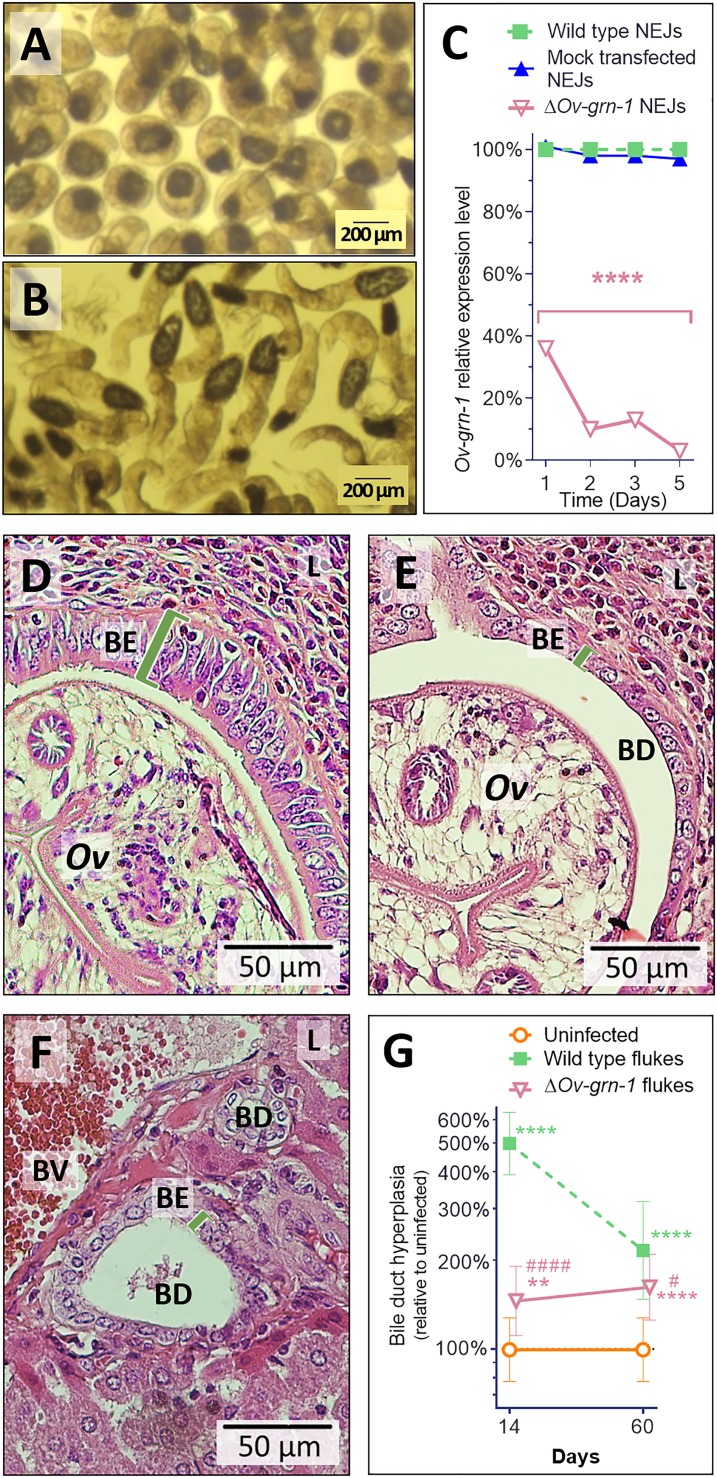
Gene edited ΔOv-GRN-1 newly excysted juveniles infected hamsters but drove reduced acute pathogenic lesions.Micrographs of metacercariae (A) and newly excysted juvenile flukes (NEJ) (B). (C) Levels of Ov-GRN-1 transcripts in mock-transfected and ΔOv-GRN-1 flukes at one to five days as quantified with qPCR and plotted relative to the wild type (WT) untreated group; mean ±SD; three replicates; ****p ≤ 0.0001 compared to WT flukes with two-way ANOVA Holm-Sidak multiple comparison test at each time point. (D) Representative micrograph (200 × magnification) of H&E-stained thin sections from livers of hamsters at 14 days after infection with WT flukes. (E) Representative micrograph of H&E-stained thin sections showing hamster liver 14 days after infection with ΔOv-GRN-1 flukes. (F) Representative micrograph of H&E stained thin sections of livers of control, uninfected hamsters, revealing the healthy, organized pavement-like profile of the cells of the biliary epithelium (BE) enclosing the lumen of the bile duct (BD), near a blood vessel (BV), within the liver (L). Infection by WT flukes (D) revealed thickened, disordered epithelium adjacent to the parasite (Ov). Infection with the gene edited ΔOv-GRN-1 flukes (E) revealed a bile duct epithelium more similar to the uninfected hamster. (G) Epithelium width/hyperplasia (green bracket) was quantified using ImageJ and plotted as the mean ±SD of five biological replicates (hamsters) from each of group and time point (14 and 60 days). Significant differences were apparent when compared to the uninfected group using the two-way ANOVA with Holm-Sidak multiple comparison test: **p ≤ 0.01 and ****p ≤ 0.0001, and wild-type compared to ΔOv-GRN-1, #p ≤ 0.05 and ####p ≤ 0.0001.